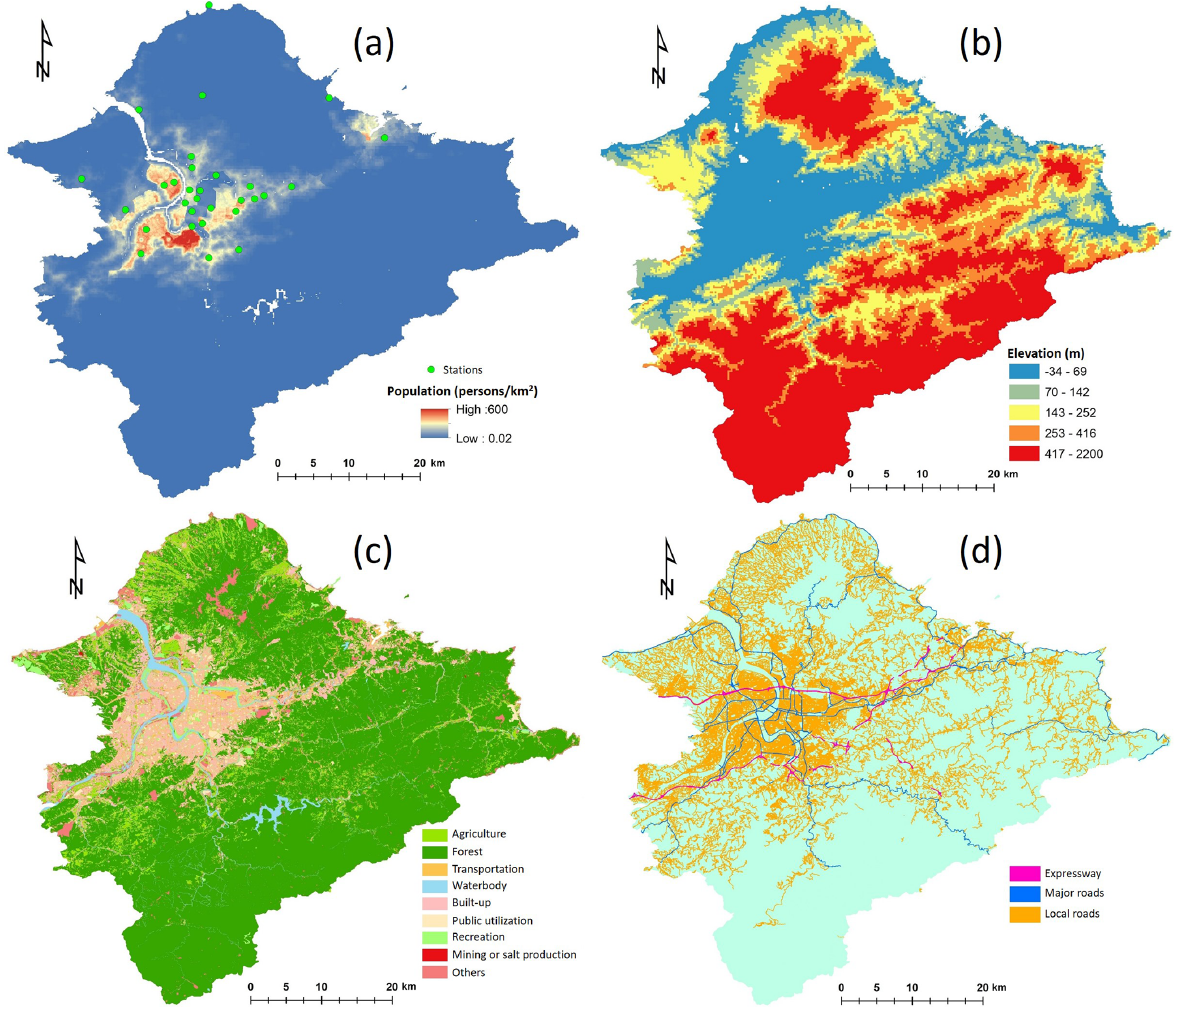
Figure 1. The characteristics of the study area. (a) Population density and the location of air-quality-monitoring stations. A total of 30 air-quality-monitoring stations were included in this study. (b) Digital elevation. (c) Land-use types. (d) The road